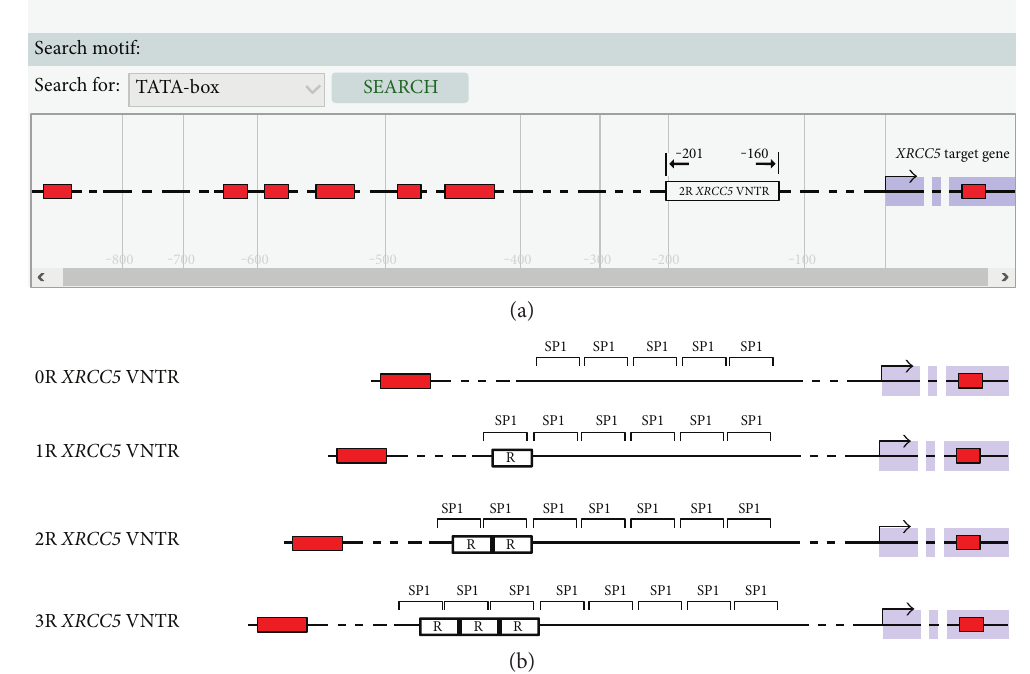
Figure 3: EPD report and schematic diagram of the di ff erent alleles of XRCC5 VNTR: (a) EPD report of the TATA-box situations and schematic diagram of VNTR (rs6147172) in the XRCC5 gene promoter; (b) schematic diagram of the di ff erent alleles of XRCC5 VNTR 0R, 1R, 2R, and 3R containing variable numbers of nuclear transcription factor